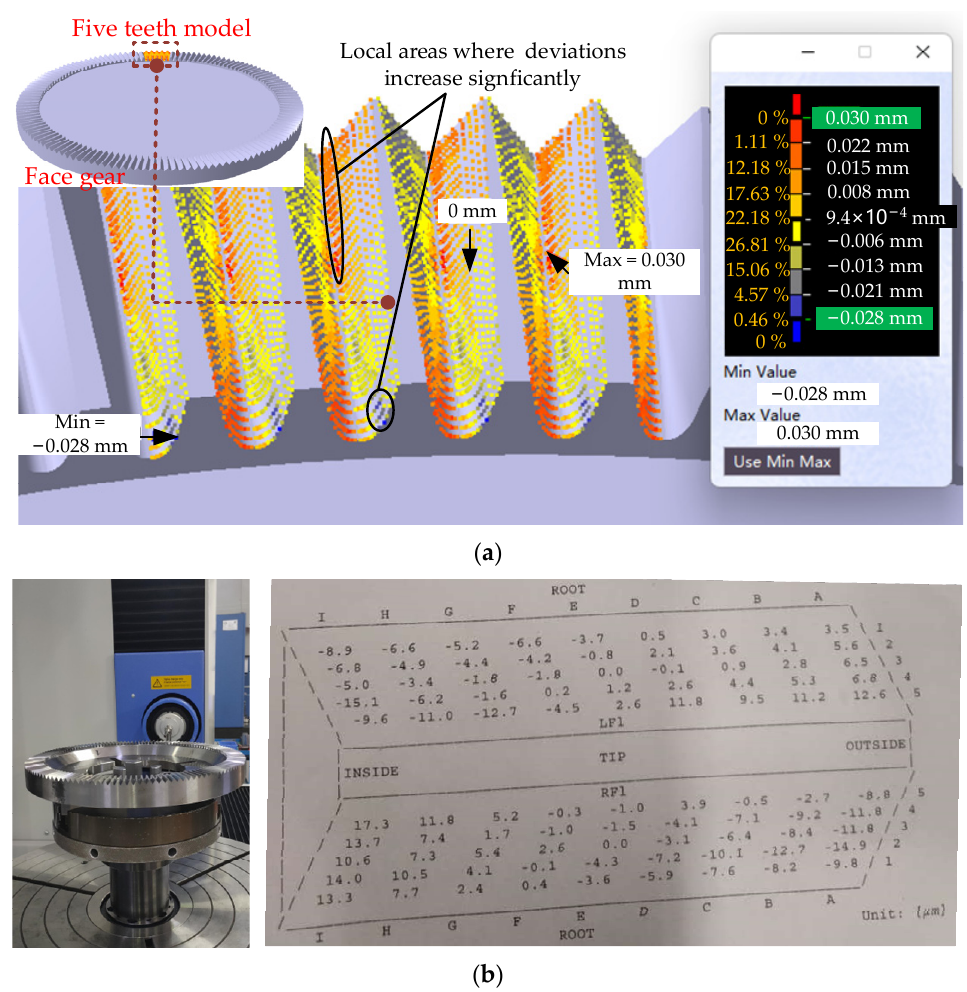
Figure 9. ( a ) Holistic deviation of the tooth surfaces obtained by the proposed method and ( b ) the measurement report of GMC.